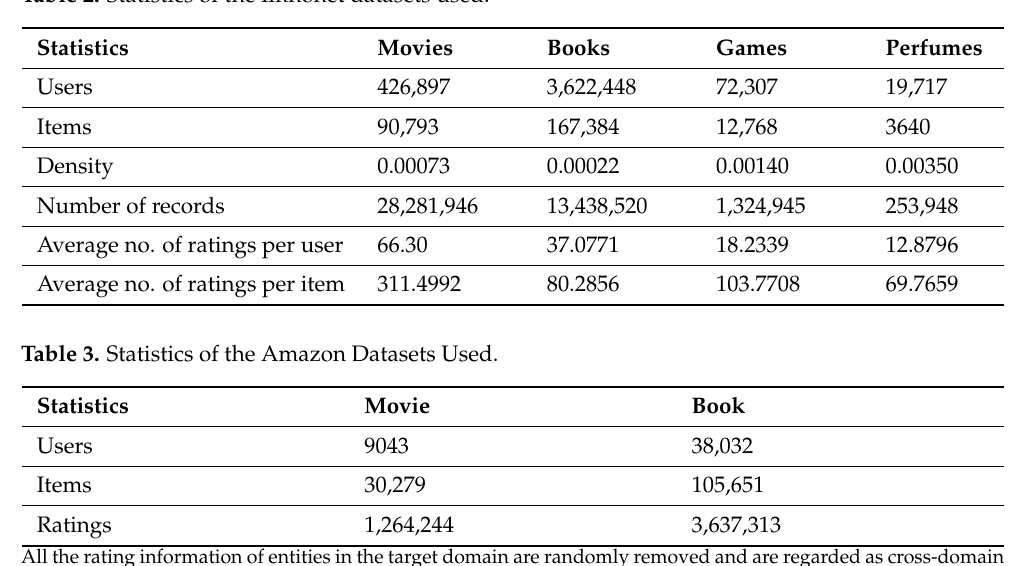
Table 2. Statistics of the Imhonet datasets used.